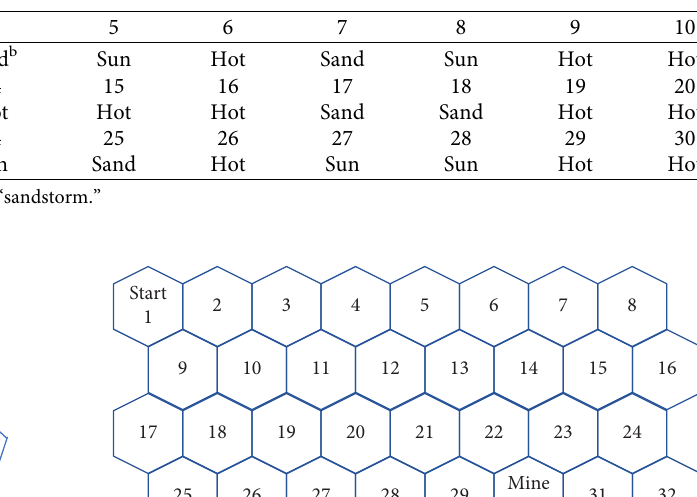
Table 4: Weather condition.